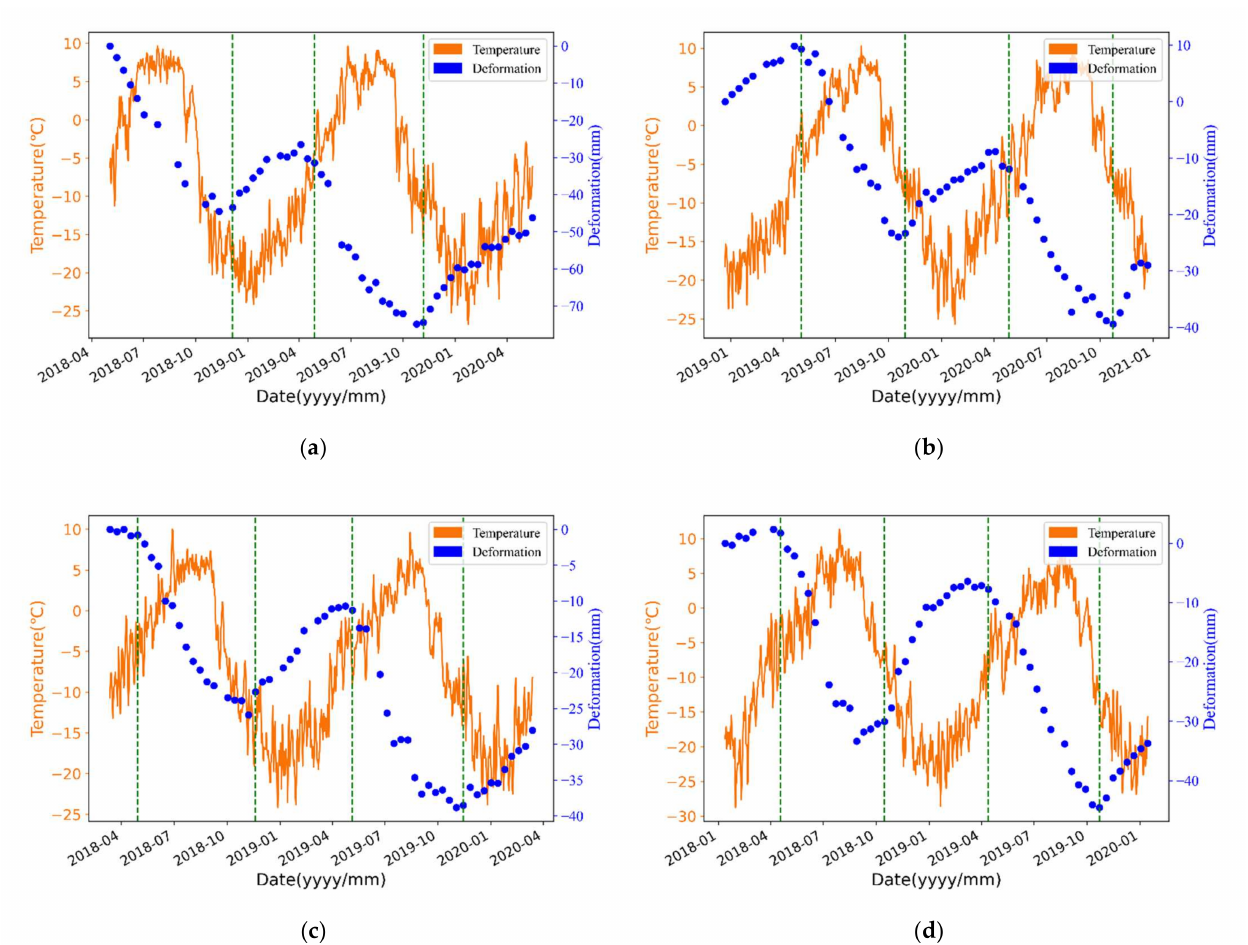
Figure 9. ( a – d ) show the time-series deformation and temperature change lines of points P1, P2, P3 and P4, respectively, in which the blue points show the time-series deformation, the yellow line is the temperature change line, and the green dotted line indicates the time point at the beginning of freezing or